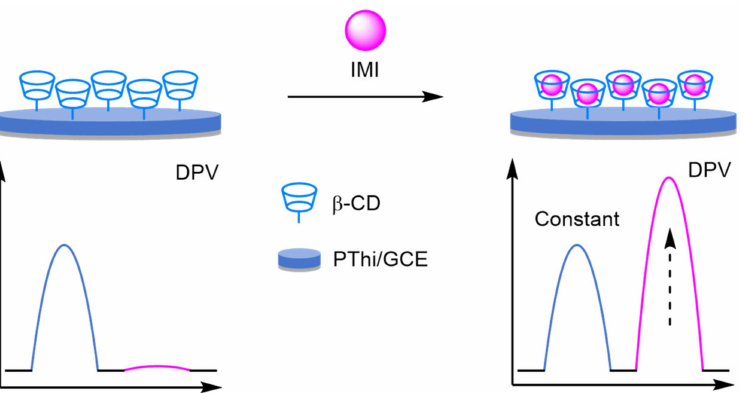
Figure 38. Schematic representation of β -cyclodextrin-based modified electrode for the detection of imidacloprid